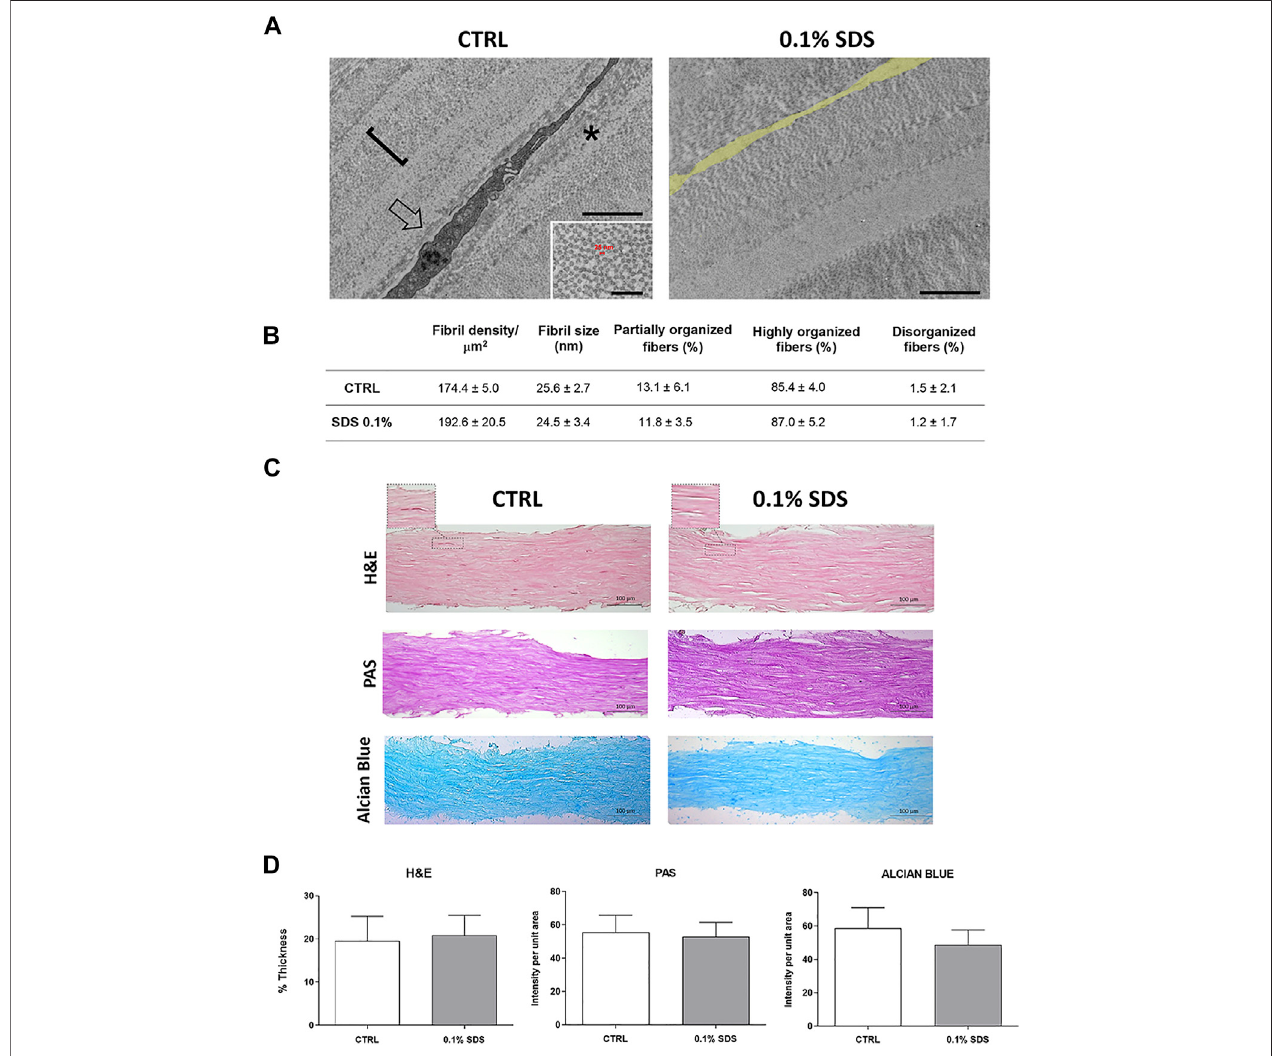
FIGURE 2 | Collagen fi brillar structure and morphology in decellularized lenticules. (A) Representative TEM images of lenticules showing a keratocyte (arrow in the left panel) or empty cell space (false labelled in yellow in the right panel), in control and 0.1% SDS-treated lenticules, respectively. Asterisk marks a partially organized collagen fi bers. Scale bar: 2 μ m (inset, 500 nm). (B) Morphometric TEM analysis of collagen fi bril size (calculated as indicated in the inset of the TEM left panel), density (one fi bril is marked with the square bracket in the TEM picture) and organization in control and 0.1% SDS-treated lenticules. Data are presented as mean ± standard deviation (SD). Signi fi cance wasassessed using a t -test (for fi bril density and size)or a chi-square test (for percentagesoforganized fi bers). (C) Representative histochemistry images of control and 0.1% SDS-treated lenticules (20x). Lenticules were stained for H&E (Thickness), PAS (Glycoprotein content) and Alcian Blue (Glycosaminoglycans content) (Scale bar 100 μ m). AuthorAnonymous, (D) Histogram shown lenticules thickness (H&E) and the quanti fi cation analysis of PAS (glycoproteins) and Alcian Blue (glycosamminoglycans) staining intensity. Data are presented as mean ± standard deviation (SD) and are compared to untreated condition ( n =